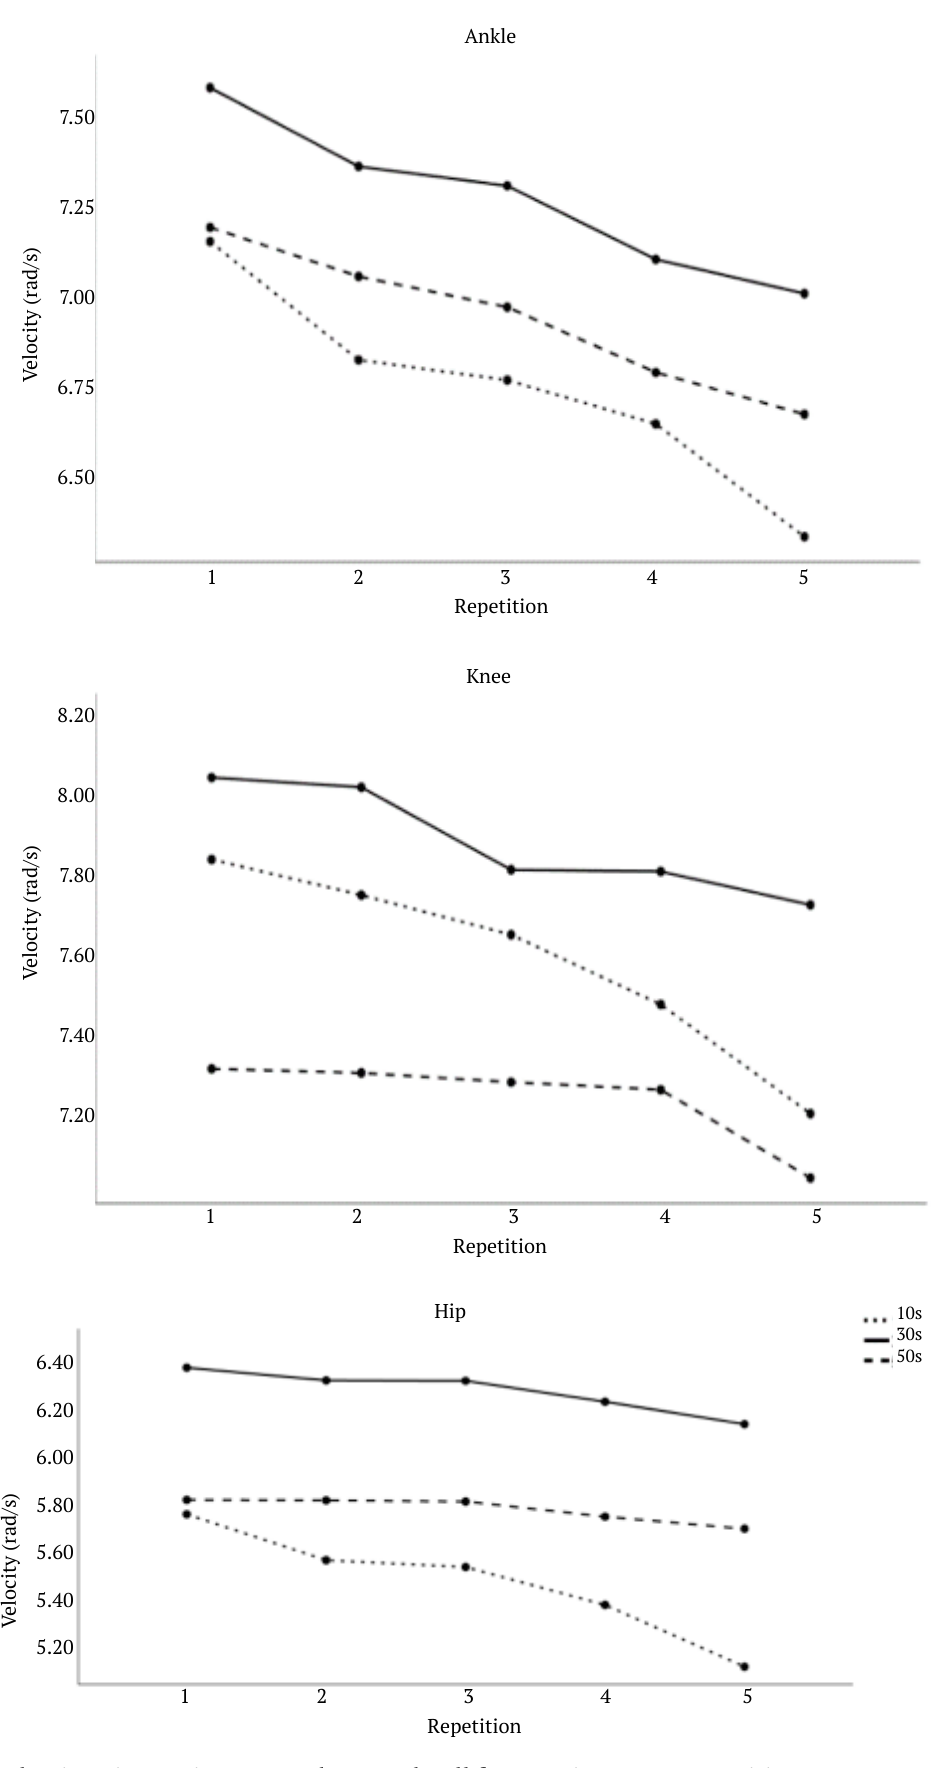
Figure 2. Peak Joint Kinematics at Snatch Second Pull from Various Inter-repetition Rest